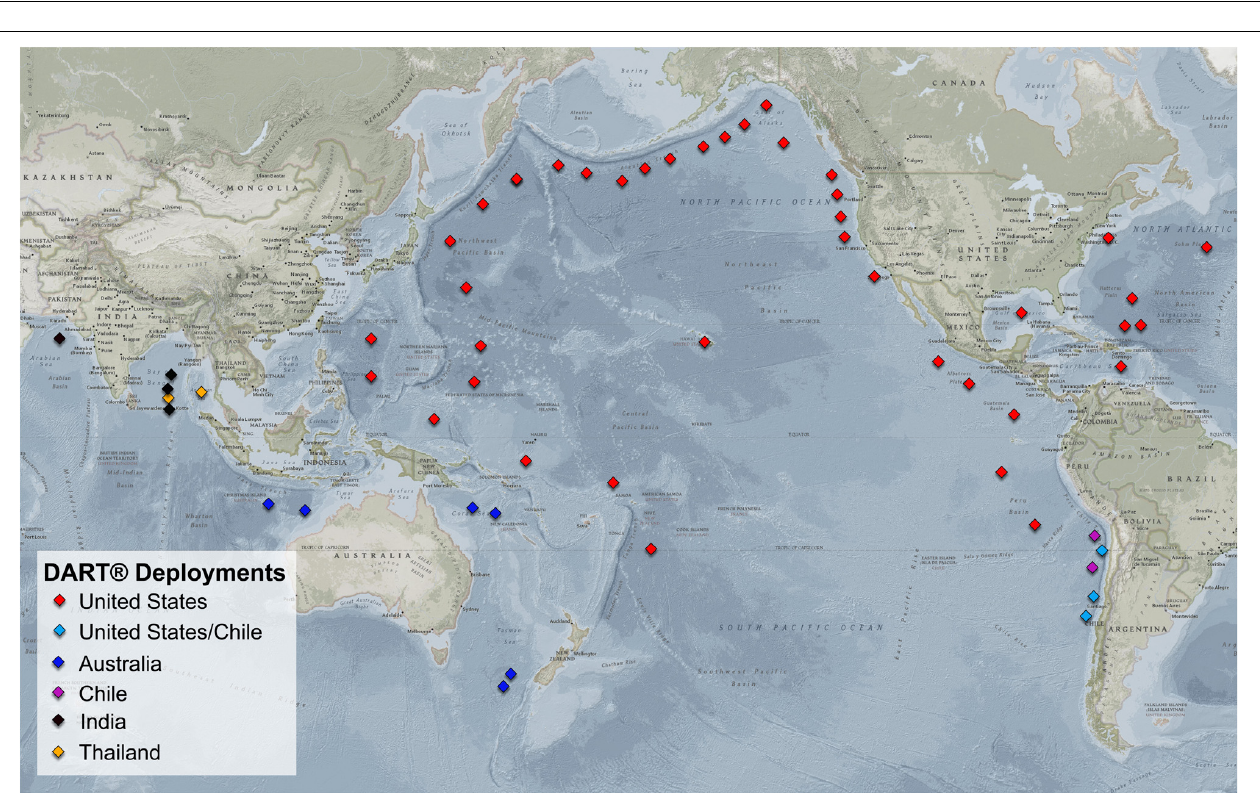
FIGURE 2 | This map illustrates the location of 2,260 real-time GNSS stations from public networks around the world. GNSS stations in non-public networks (e.g., in Japan, Mexico, and Chile) are not shown here but could also support tsunami warning. Source: Pacific Northwest Geodetic Array/Central Washington University.